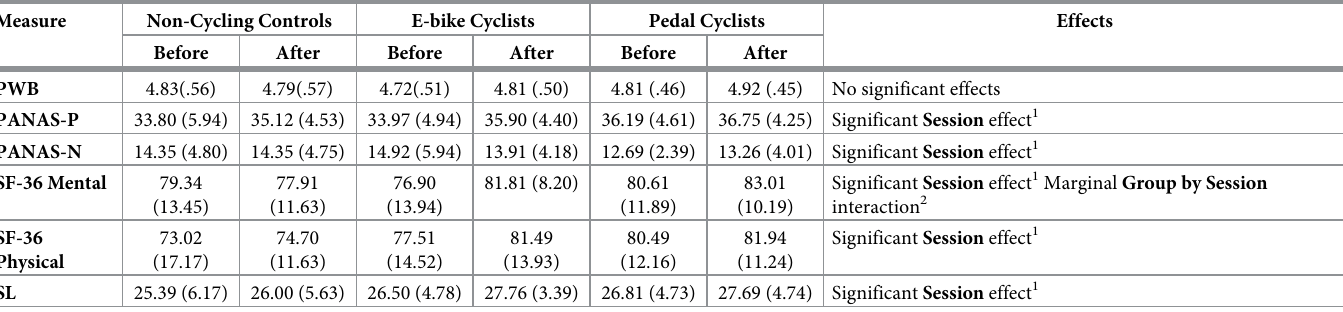
Table 5. Group (non-cycling controls, e-bike cyclists, pedal cyclists) means (SDs) for psychological wellbeing (PWB), positive and negative affect scale positive score (PANAS-P) and negative score (PANAS-N), SF-36 mental (SF-36 mental) and physical health (SF-36 physical) and life satisfaction (SL). Measure Non-Cycling Controls